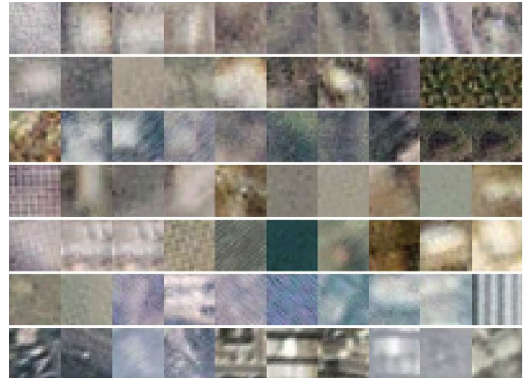
Figure 2: Example of images in the PlanesNet dataset labeled as the “no-plane” category.